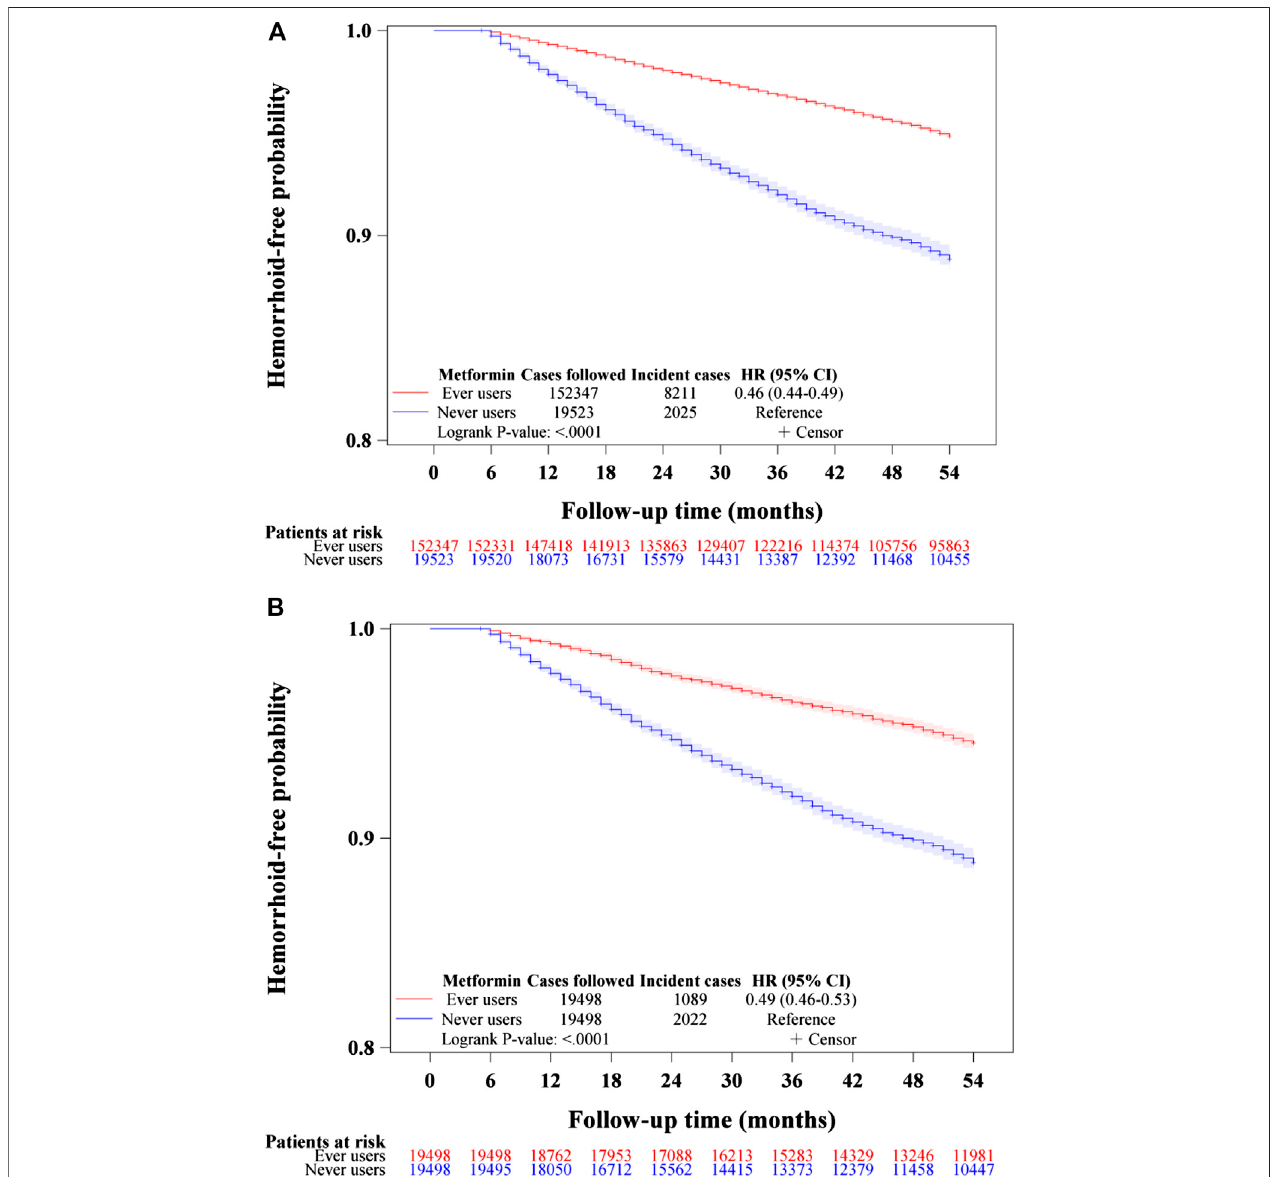
FIGURE2| Kaplan – Meiercurvescomparing hemorrhoid-free probabilityinnever users and ever users ofmetformin intheunmatchedcohort (A) and thematched cohort (B) . HR: hazard ratio, CI: con fi dence interval.